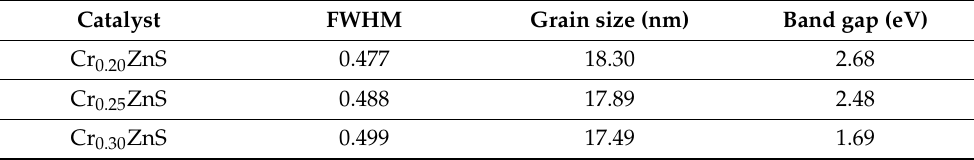
Table 2. The band gap and grain size of Cr x ZnS catalyst samples.